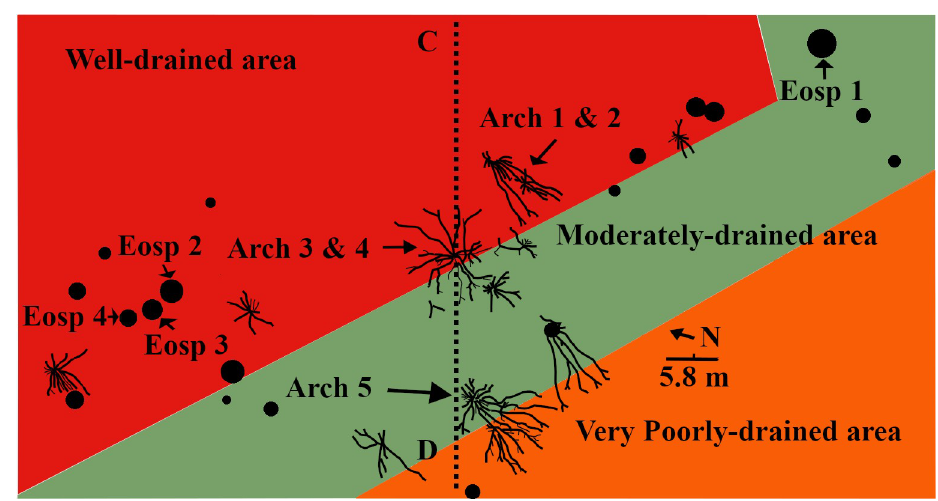
Fig 3. The distribution of the fossilized root systems belonging to three different tree clades. The tree distributions at the TCHD were mapped using Stein’s map as base-map [11]. Stein’s map only covered the exposed fossils around the C-D cross-section (Fig 2). Arch stands for Archaeopteris , Eosp for Eospermatopteris , and Lyc Tree for the lycopsid tree. Note L- shaped distributions of the Eosp trees in the form of the two clusters (one around Eosp 1, and another around Eosp 2). Likewise, note the distribution of the Arch tree from Arch 1 to Arch-5. The linear distribution extends to Arch 6 which is not shown in this map. The colors in the map represent the dominant drainage patterns in the fossilized landscape that were inferred from the redox coloration. The actual surface paleosol colors were light-red, dark-gray, and yellowish-brown indicating the existence of a drainage gradient from well-drained, moderately drained to poorly drained area.